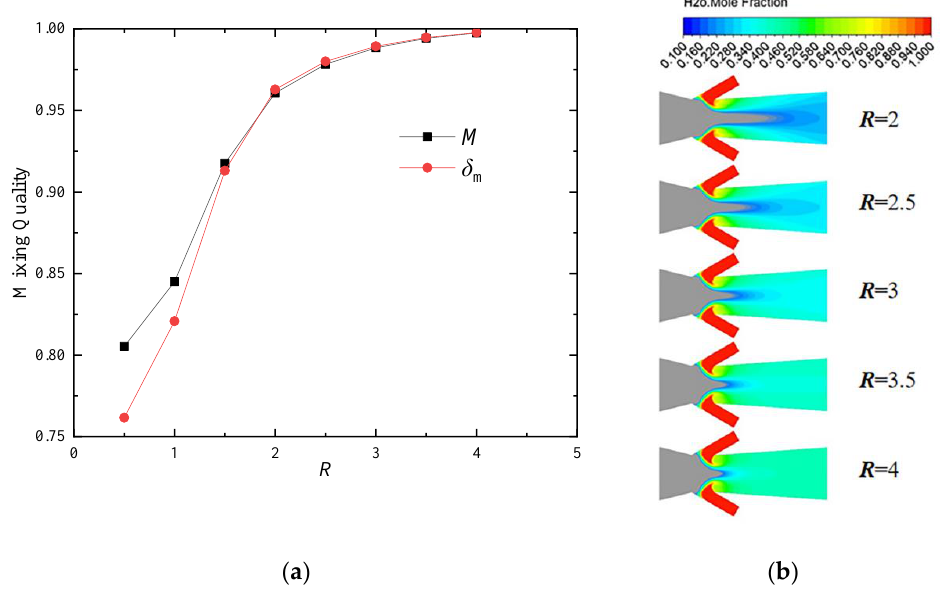
Figure 21. The effects of R on ( a ) M and ( b ) concentration distribution of jetting flow in VTM.